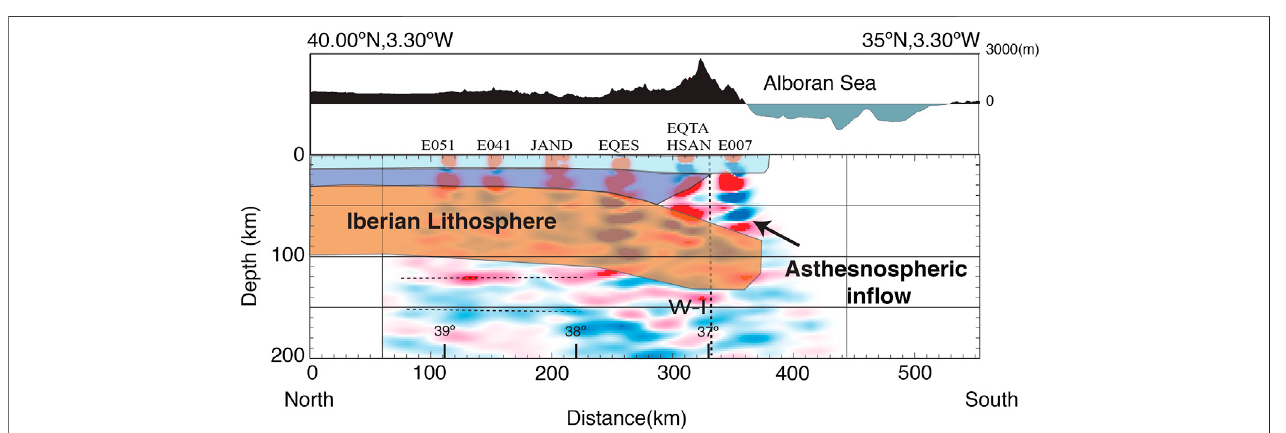
FIGURE 12 | Comparison of the common conversion point migration image of P-receiver function built using only the closest stations to the pro fi le (modi fi ed from Figure 9 of Mancilla et al., 2015a) with the simulated structure of the Iberian lithosphere for the Reference Model at 5.4 Myr. At the top, we display the topography along the pro fi